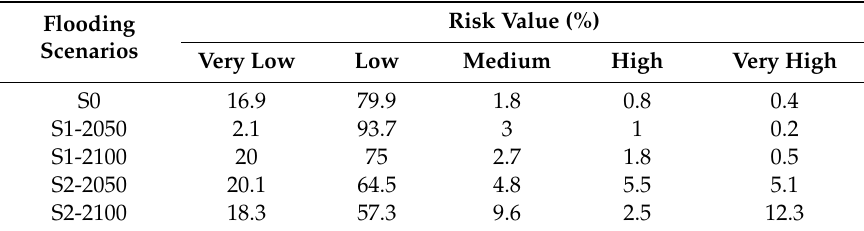
Figure 6. Coastal flooding risk under various scenarios in Bandar Abbas City. Table 7. Percentage area of risk classes for various coastal flooding